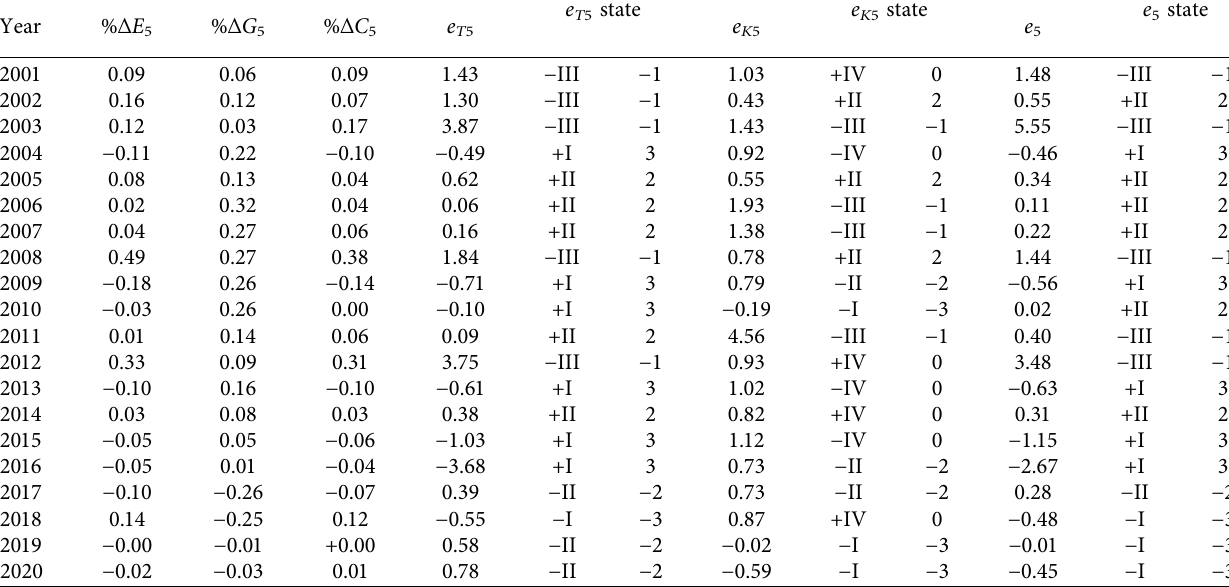
Table 12: Decoupling index and decoupling relationship of the nonmetallic sector from 2001 to 2020.